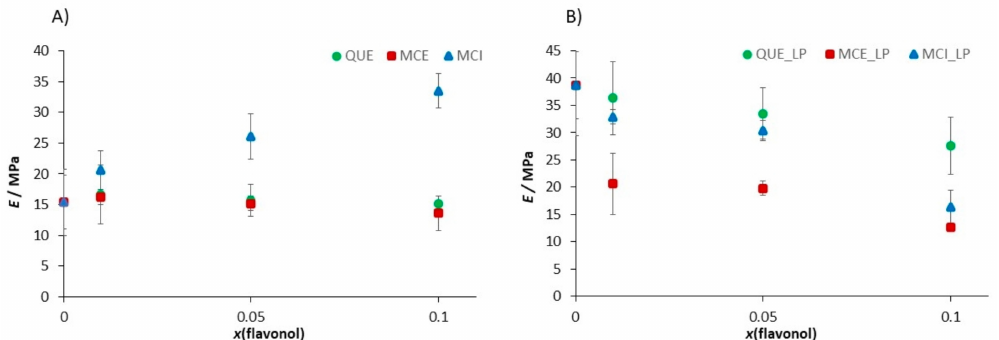
Figure 13. The change of the Young’s modulus value induced ( A ) by the insertion of the flavonols in dependence of the molar fraction of inserted flavonols and ( B ) by the induced lipid peroxidation process in the SLB as a function of the molar fraction of inserted